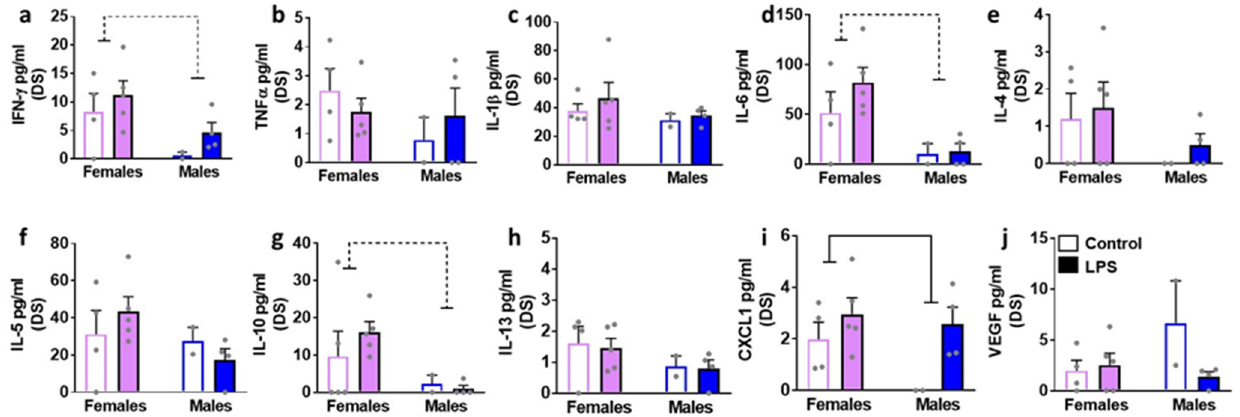
Figure 5. Cytokines, chemokines, and VEGF were measured in the dorsal striatum (DS) of female and male rats that were exposed to saline or LPS challenges. Pro-inflammatory cytokines are indicated in panels ( a – d ). Anti-inflammatory cytokines are indicated in panels ( e – h ). Chemokine is indicated in panel ( i ) and angiogenesis marker is indicated in panel ( j ). Data are represented as mean ± S.E.M. n = 4 control female, n = 5 LPS female, n = 2 control male, n = 4 LPS male. Main effect of LPS ( p < 0.05) is indicated by solid line with flat arrowheads, and main effect of sex ( p < 0.05) is indicated by dashed line with flat arrowhead.